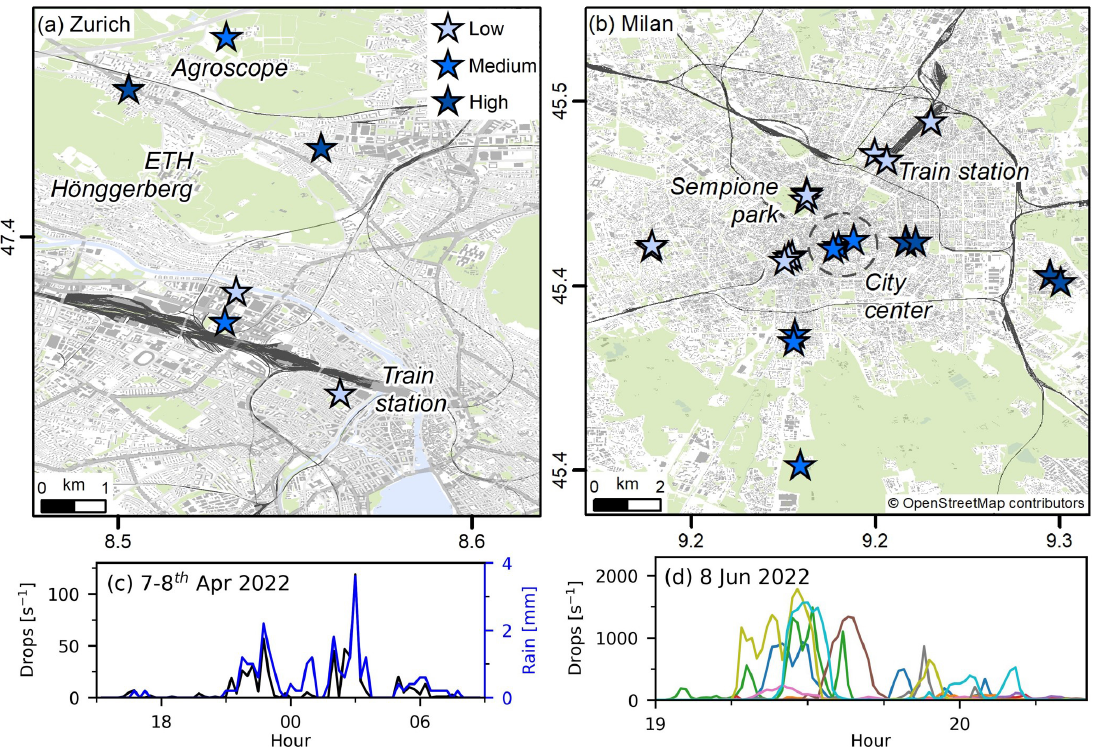
Figure 2. Locations of 6 low-sensitivity (cave-designed) acoustic sensors in Zurich ( a ; a single sensor is located at each site) and 29 high- sensitivity acoustic sensors in Milan ( b ; 2–3 sensors are located at each site). The color of the star indicates how many raindrops were counted in April 2022 in Zurich (medium range: 28000–32000) and in June 2022 in Milan (medium range: 8000–33000). Background city maps are based on OpenStreetMap data, which are available under the Open Database License. In panel (c) , a rainfall event in Zurich is shown, comparing acoustic sensor data (black line, recording drops) with data obtained from the nearby meteoblue AG rain gauge (blue, recording rainfall depth). We present in panel (d) an example of spatial rainfall variability observed in Milan by the acoustic sensors (each color represents a different